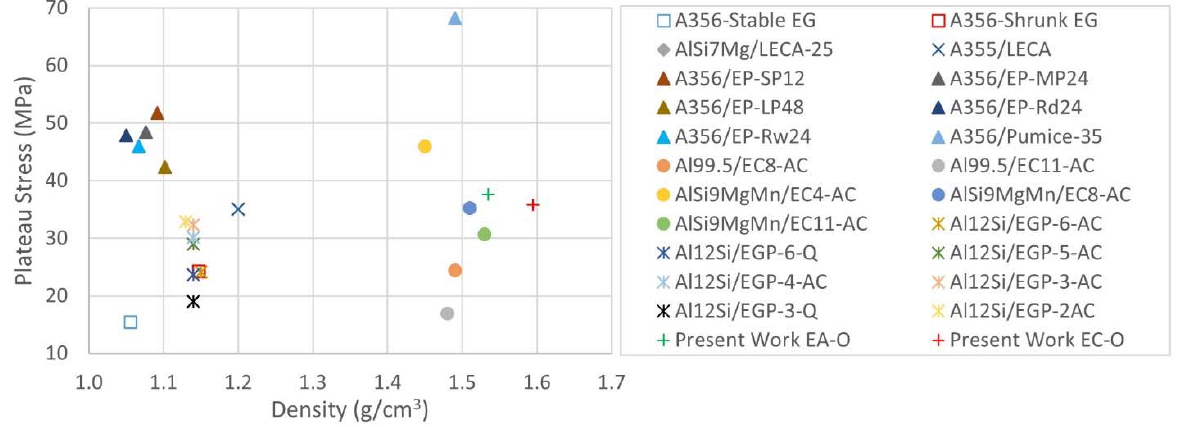
Figure 10. Comparison of average values of plateau stress of ASF-embedding porous fillers [11– 15,20–22].